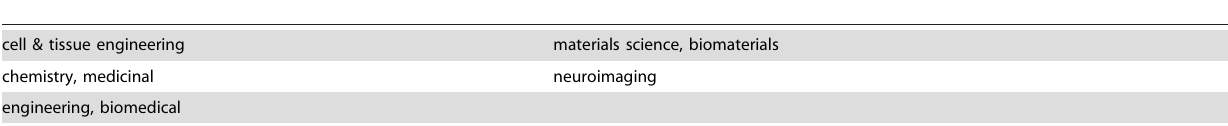
Table 2. The five life science fields included in the analysis.